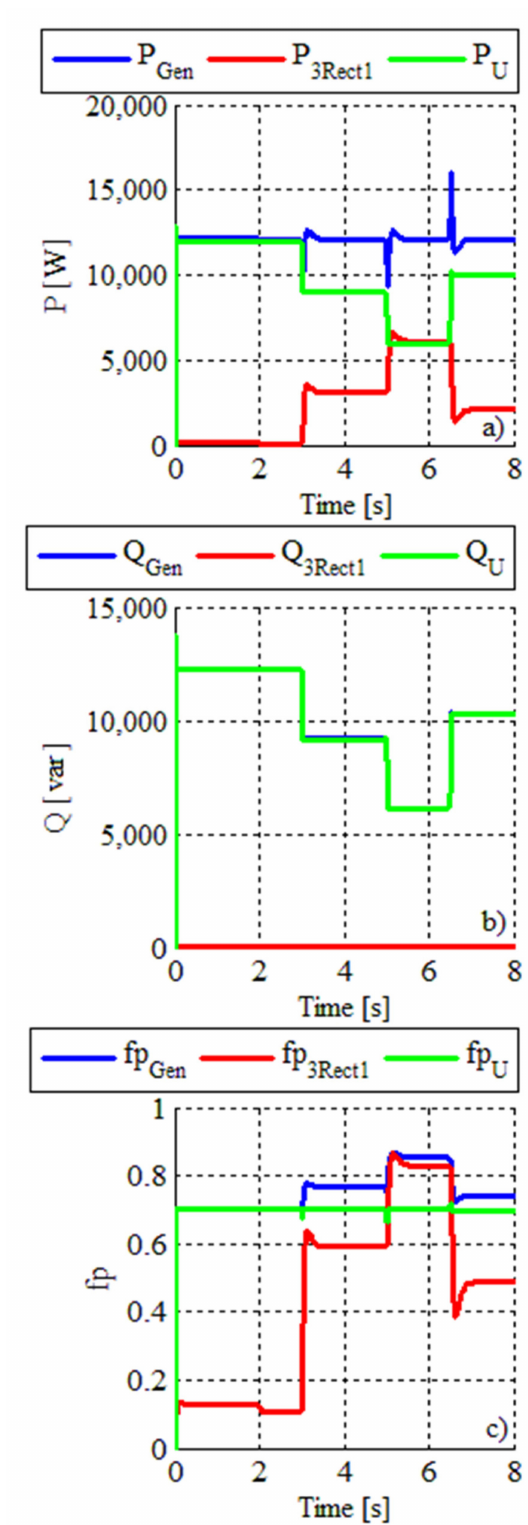
Figure 12. Graphics for ( a ) active power; ( b ) reactive power; and ( c ) the power factor with single- phase rectifiers and symmetrical